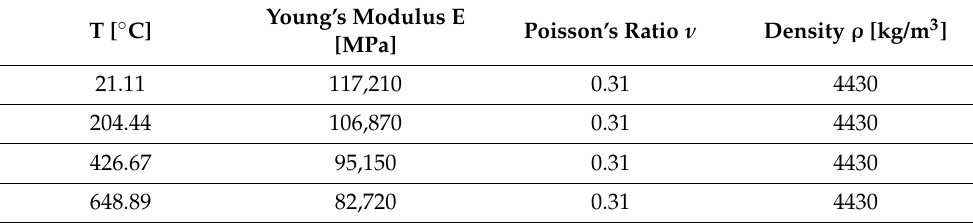
Table 2. Mechanical properties of the titanium alloys Ti-6Al-4V [30,31].